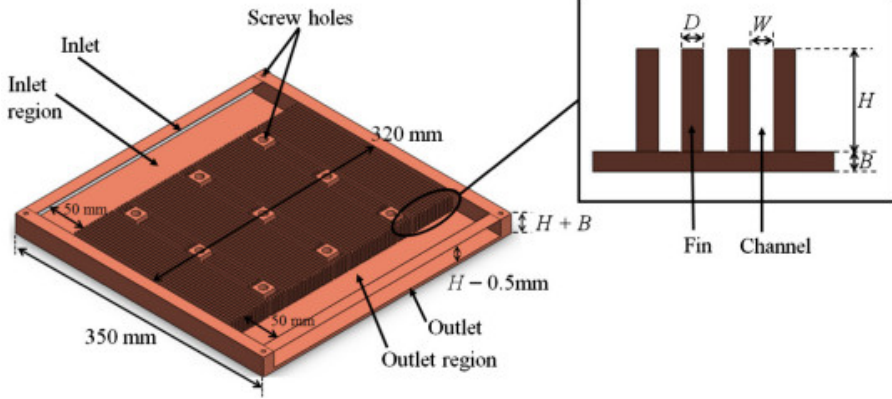
Figure 28. A detailed schematic diagram of the microchannel heat receiver design showing two important variables in the configuration of heat sink: fin thickness (D) and fin height (H) [125]. Other symbols: W—spacing between fins, B—base thickness. Reprinted with permission from Ref. [125]. 2017, Elsevier.